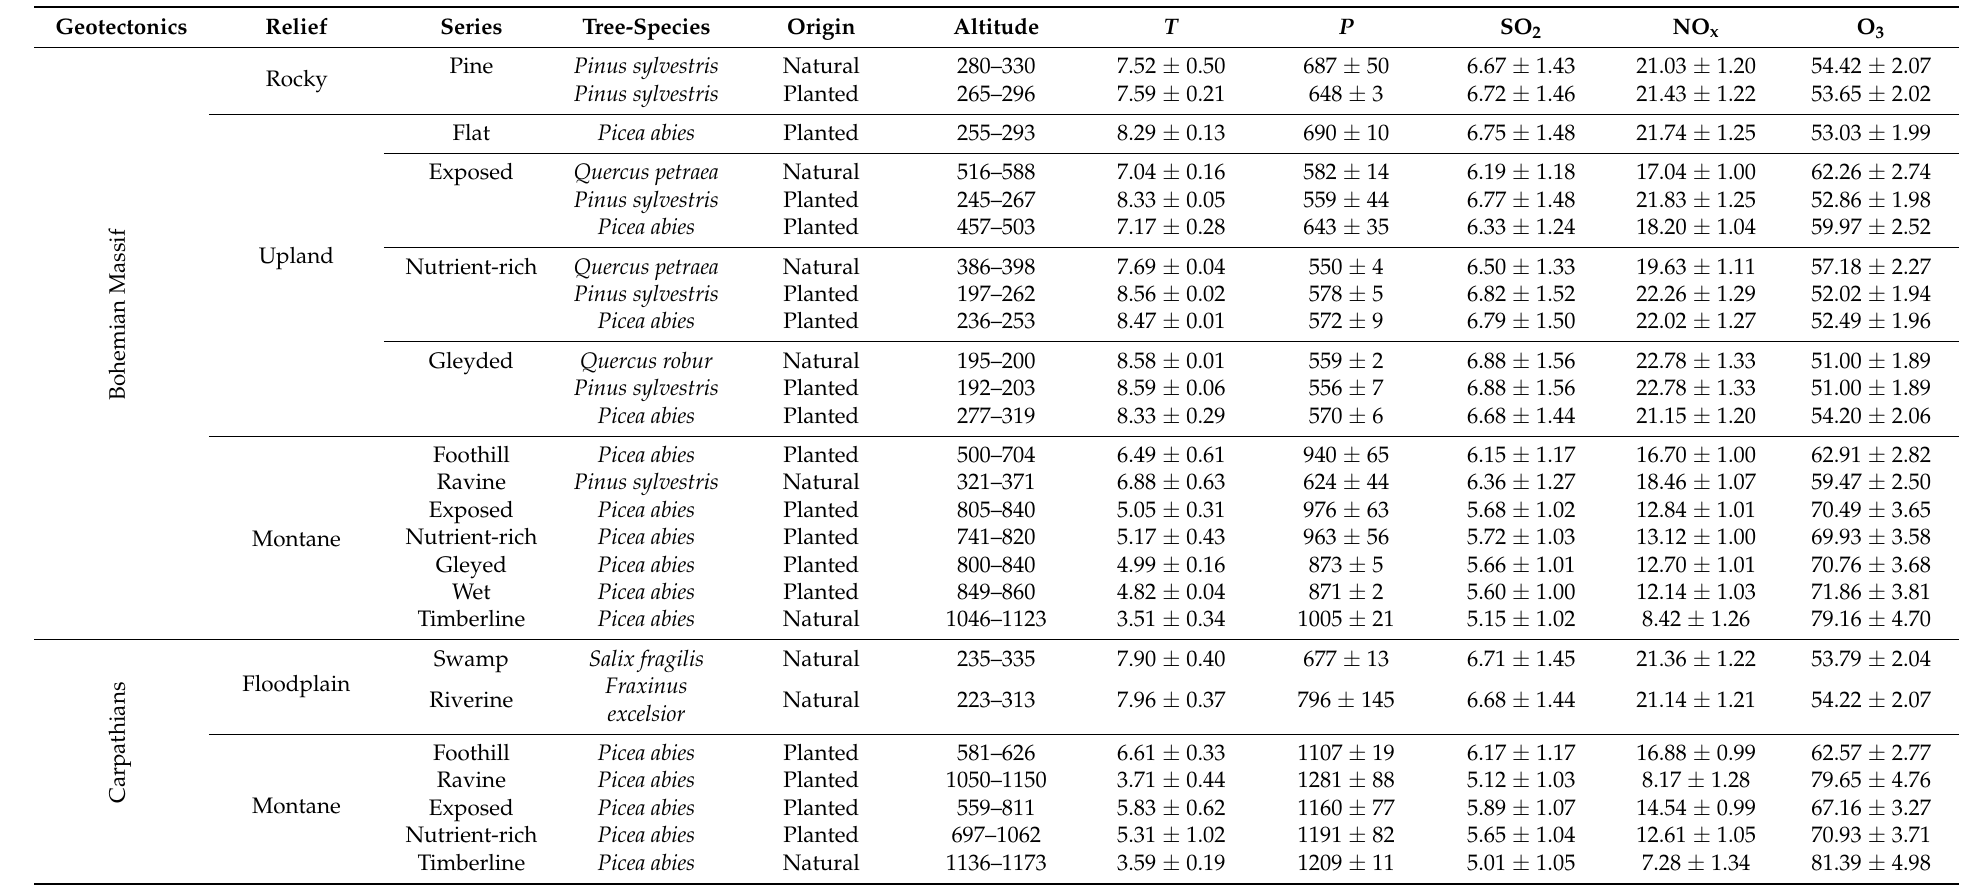
Table 2. Air condition characteristics of sampled forest stand types (mean ± standard